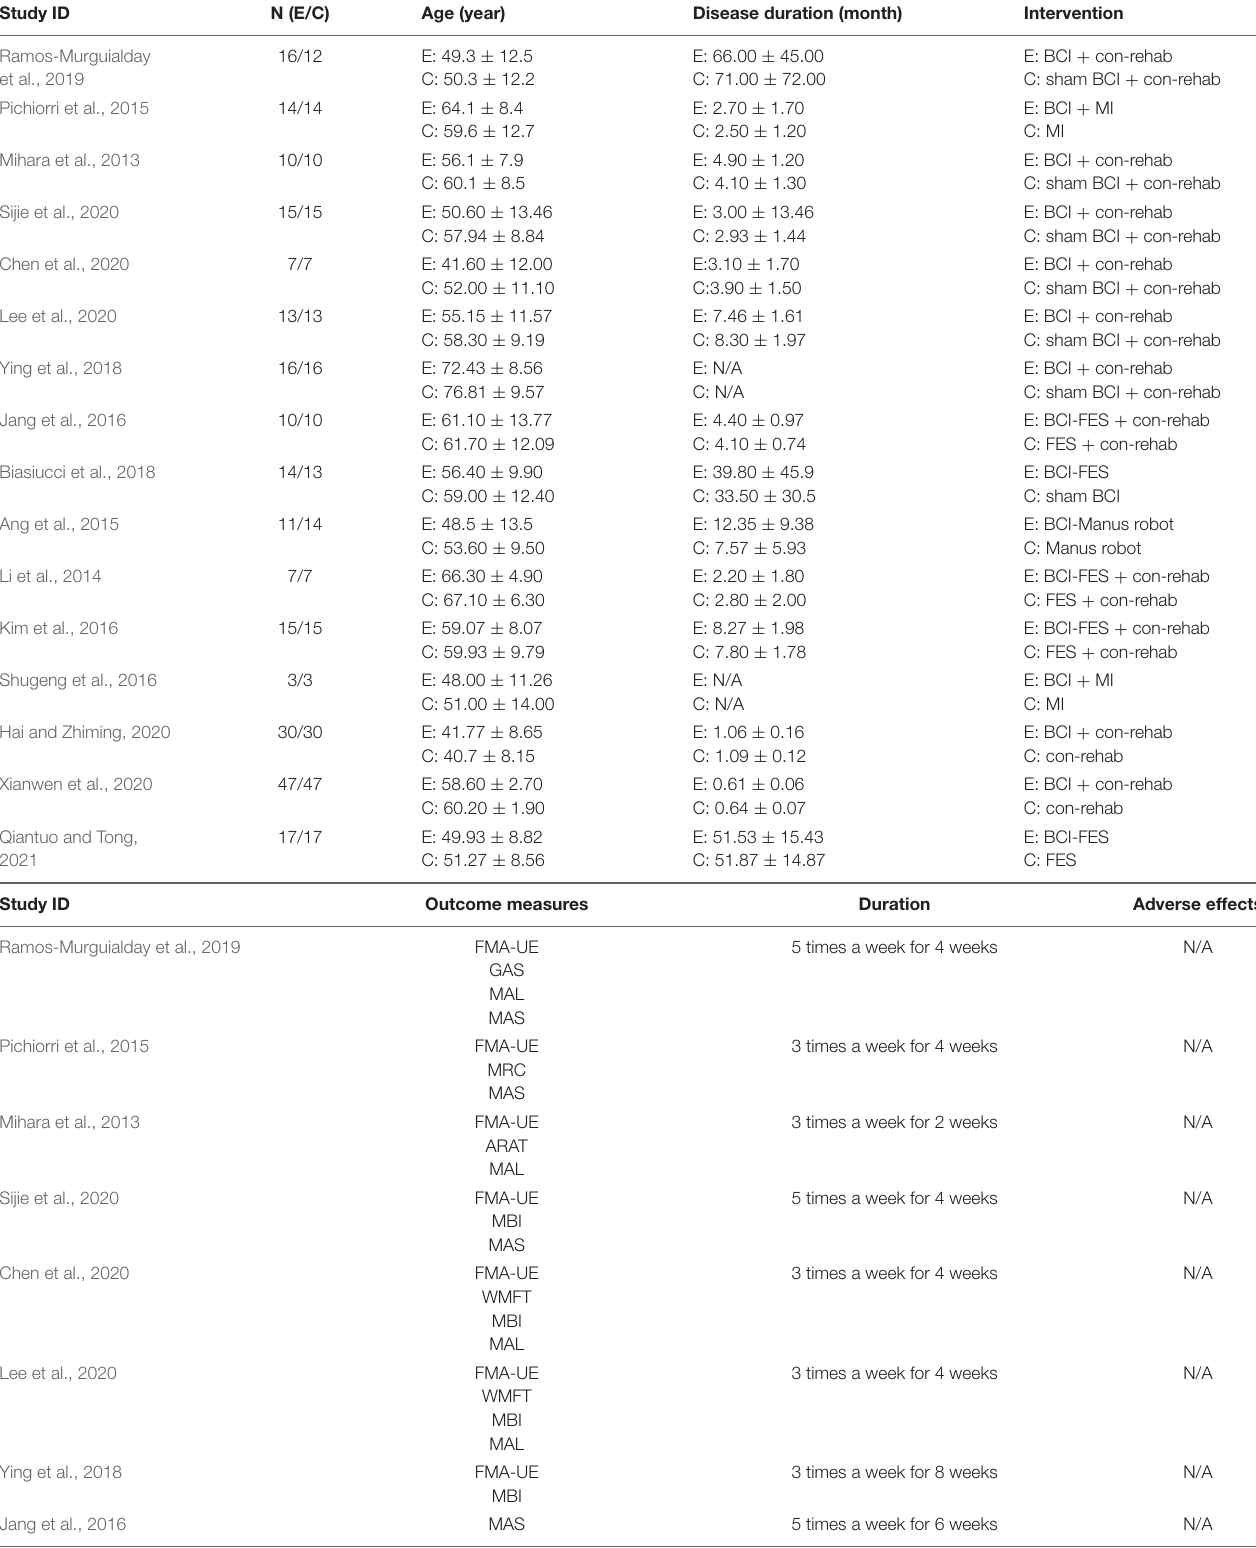
TABLE 1 | Characteristics of the included clinical trials involving brain-computer interface for the treatment of central nervous system disease. Study ID N (E/C) Age (year) Disease duration (month)